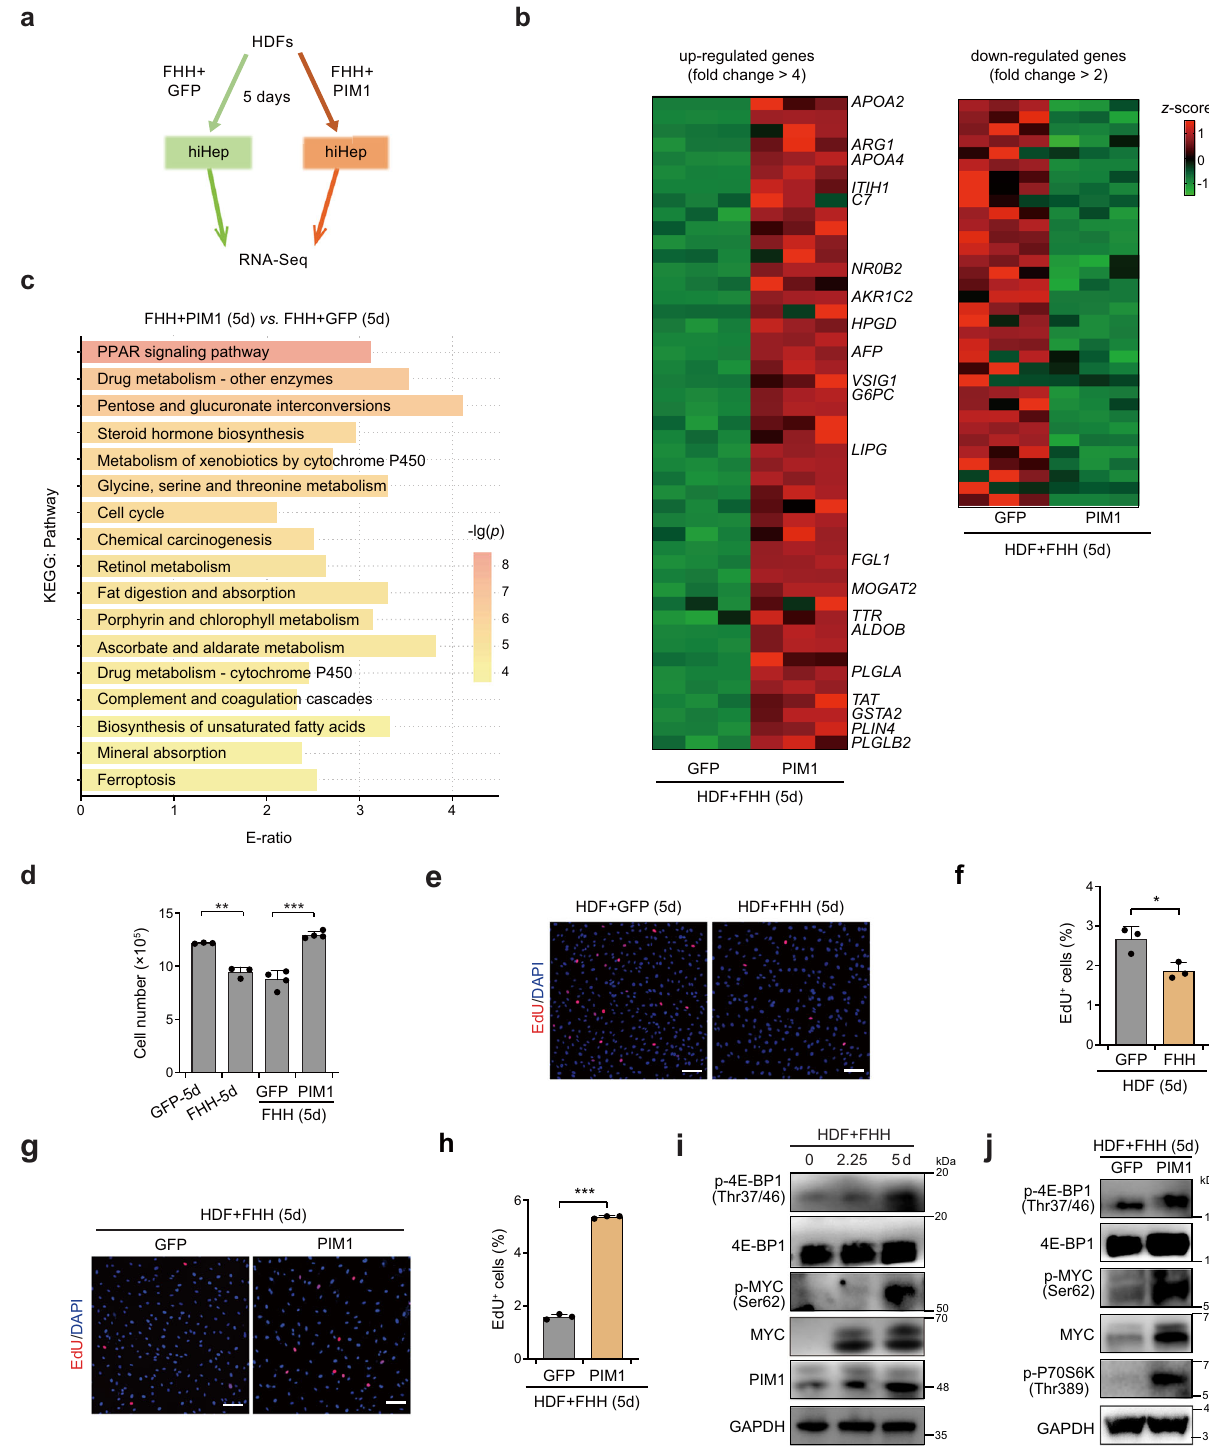
Fig.5|AnalysisofPIMinreprogramming-inducedcellcyclearrest.a Diagramof the experimental design. b Up-regulated genes (fold change > 4) and down- regulated genes (fold change > 2) in response to PIM1 overexpression in HDFs transfected with FHH for 5 days ( n = 3). The names of liver- or fetal liver-enriched genes (based on BioGPS data) are shown at right. c KEGG-based enrichment ana- lysisofDEMsderivedfrom GFP -or PIM1 -overexpressingHDFsinfectedwithFHHfor 5 days. d Cell numbers after introduction of the indicated genes into HDFs for 5 days (GFP-5d vs. FHH-5d p = 0.0007 n = 3, FHH+GFP(5d) vs. FHH+PIM1(5d) p <0.0001 n =4).Representativeimage( e )ofEdUpositivecellsonday3ofhepatic reprogrammingusingtheEdUstainingassay( n =3biologicalreplicates).TheEdU+ cellswerequanti fi edbya fl owcytometer( p =0.0224, n =3biologicalreplicates)( f ).